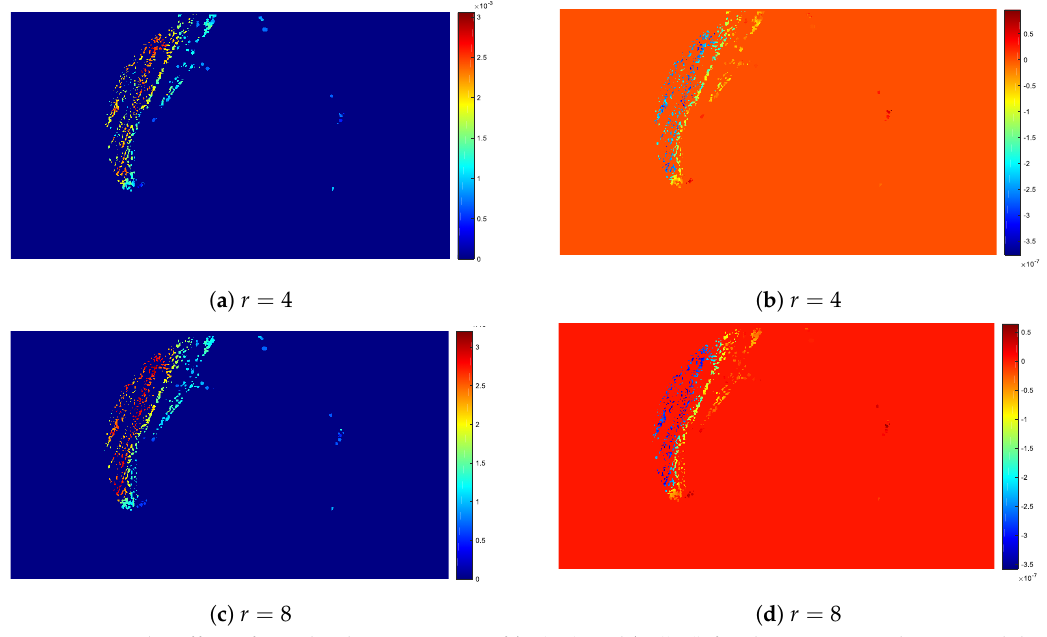
Figure 14. The effect of r to the determination of b 2 ( a , c ) and b 1 ( b , d ) for the LFSD population model are shown for r = 4,